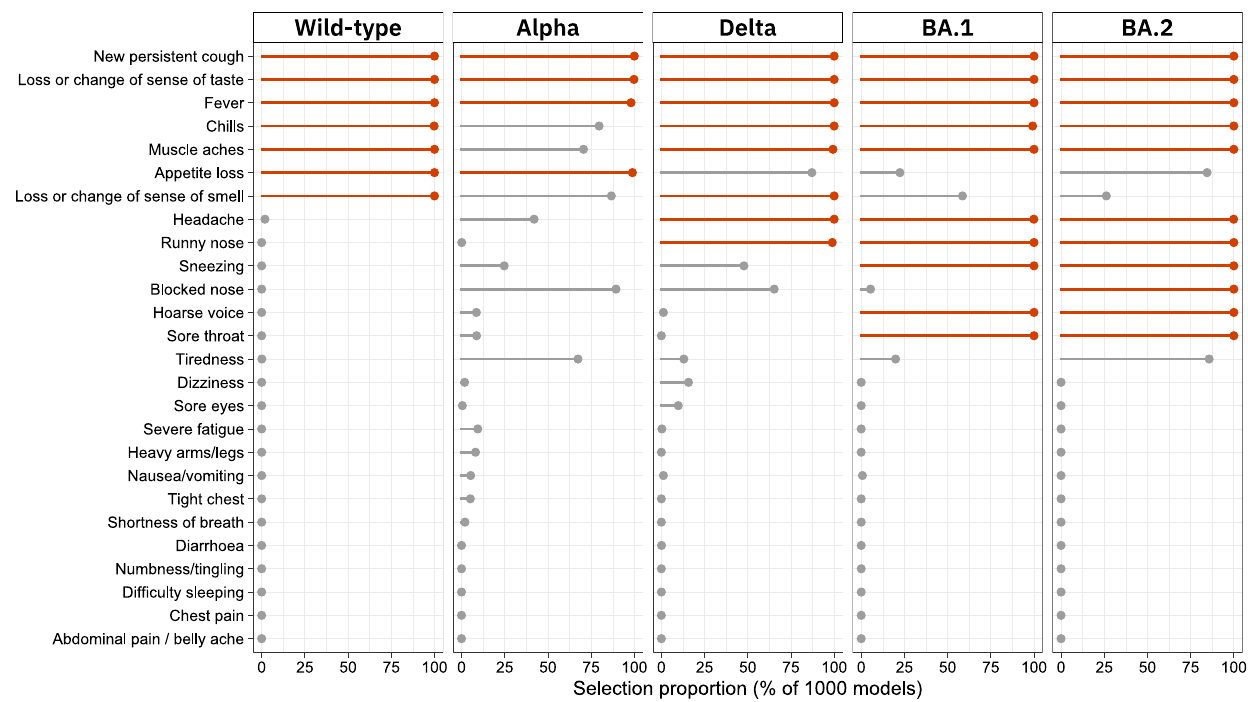
Fig. 3 | Results of LASSO stability selection proportions with swab positive/ negative as the binary outcome variable and each of 26 symptoms as pre- dictors, for fi ve SARS-CoV-2 variants in England. Age, sex and, where appro- priate, vaccination status are forced into the models as unpenalised variables;